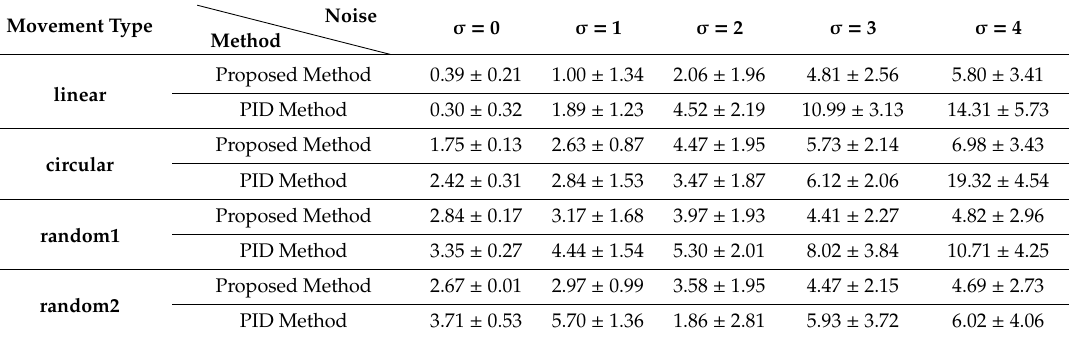
Table A2. Tracking results of UAV in the sensor noise environment. The root-mean-square error in the x -axis direction and data confidence interval are shown in this table.